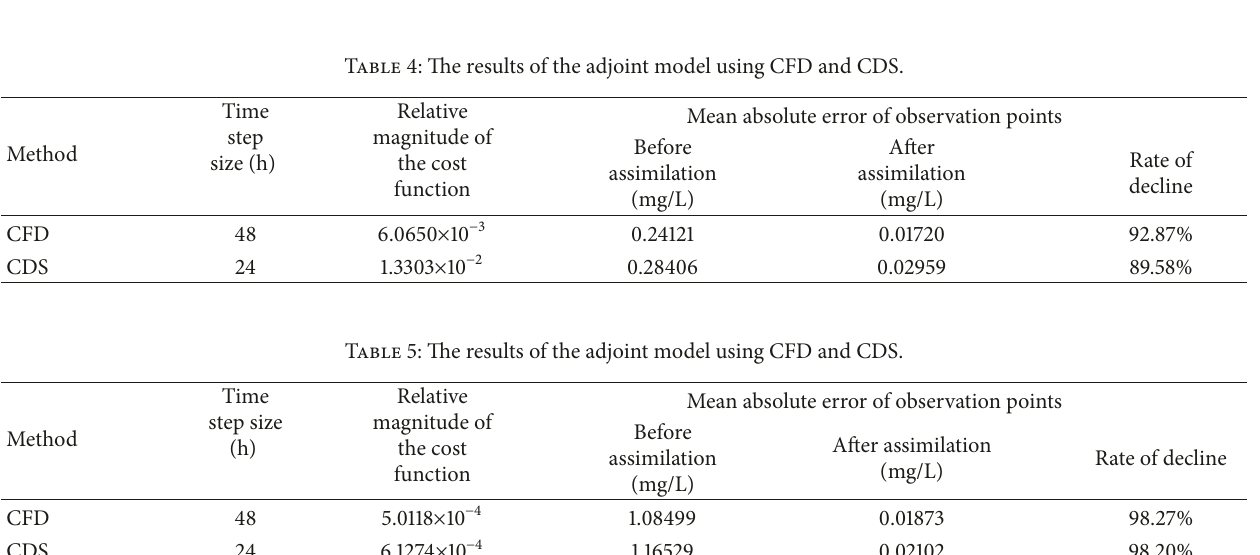
Figure 8: The descending curves of the relative magnitude of the cost function 𝐽/𝐽 1 and the mean absolute error (MAE) of observation points using CFD and CDS with different time steps.